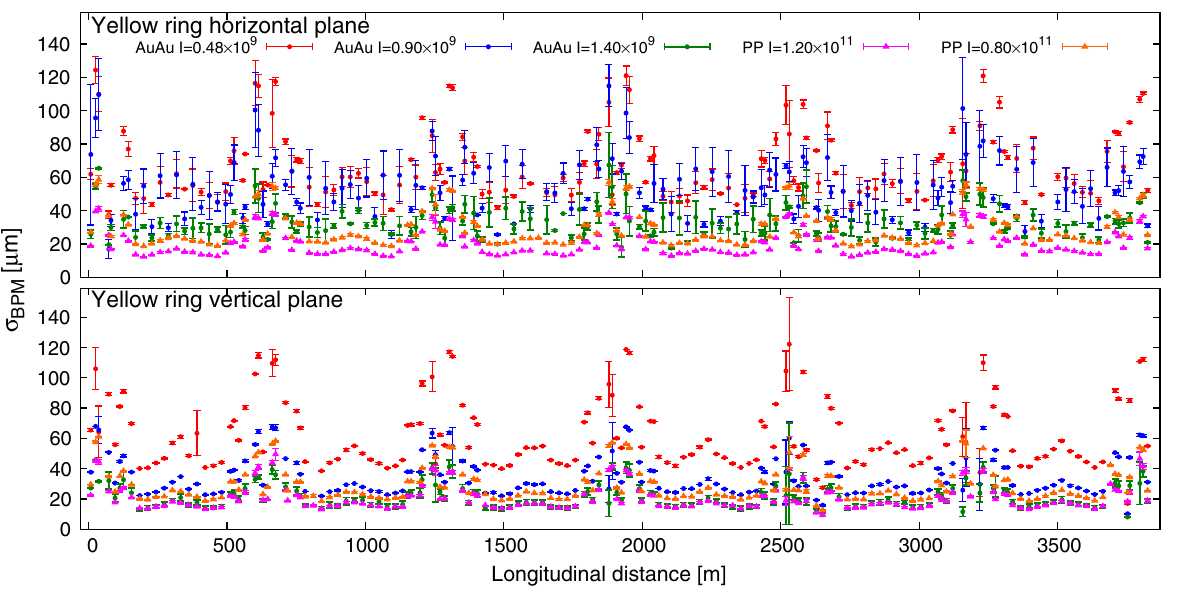
FIG. 4. Estimated standard deviations of BPM noise from TBT BPM data of 2013 polarized proton operation with two different intensities and 2014 Au 79 þ operation with three different intensities. Error bars reflect statistical standard deviations of estimated noise over three sets of experimental data.